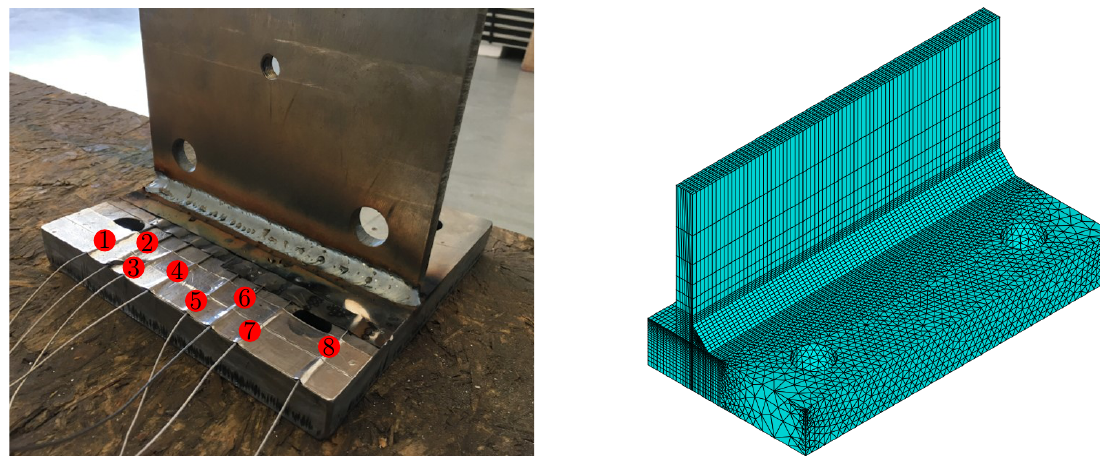
Figure 10. Experimental set-up for temperature measurement ( left ) and FE-model ( right ) of the simplified specimen.